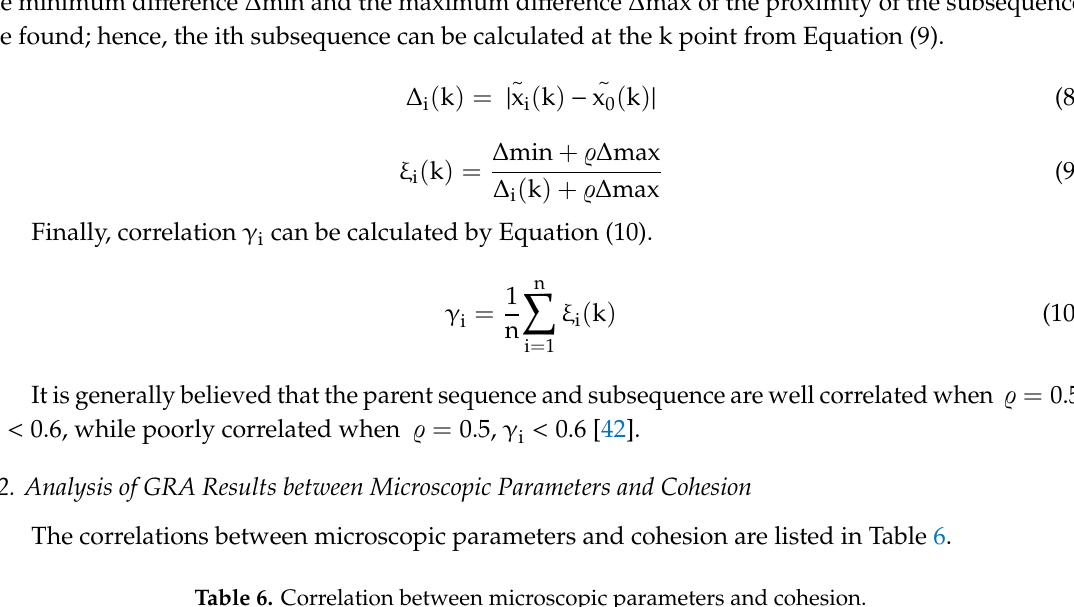
Table 6. Correlation between microscopic parameters and